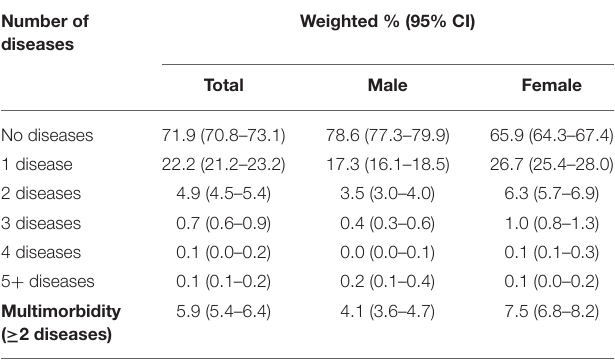
TABLE 3 | Estimated number of diseases in individuals by sex